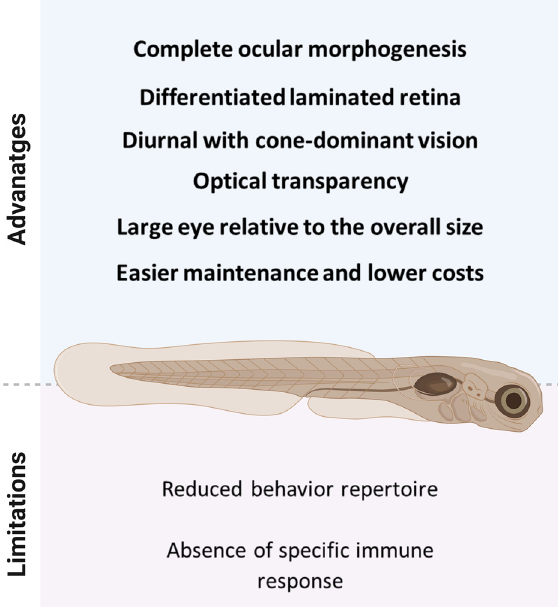
Figure 1. Experimental advantages and limitations of 72 h post-fertilization zebrafish larvae.